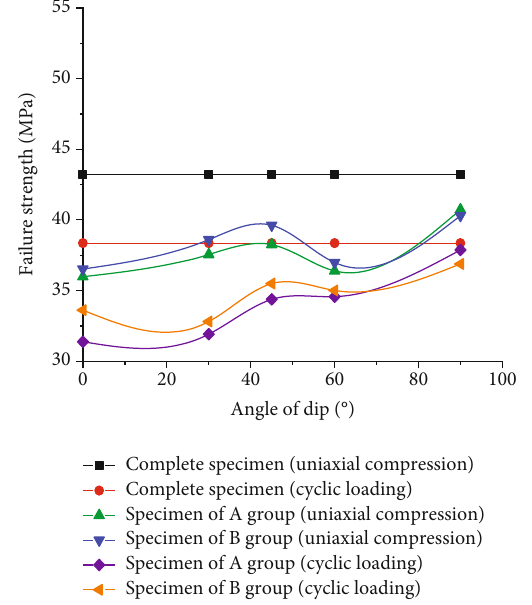
Figure 6: Failure strength of rocklike samples.